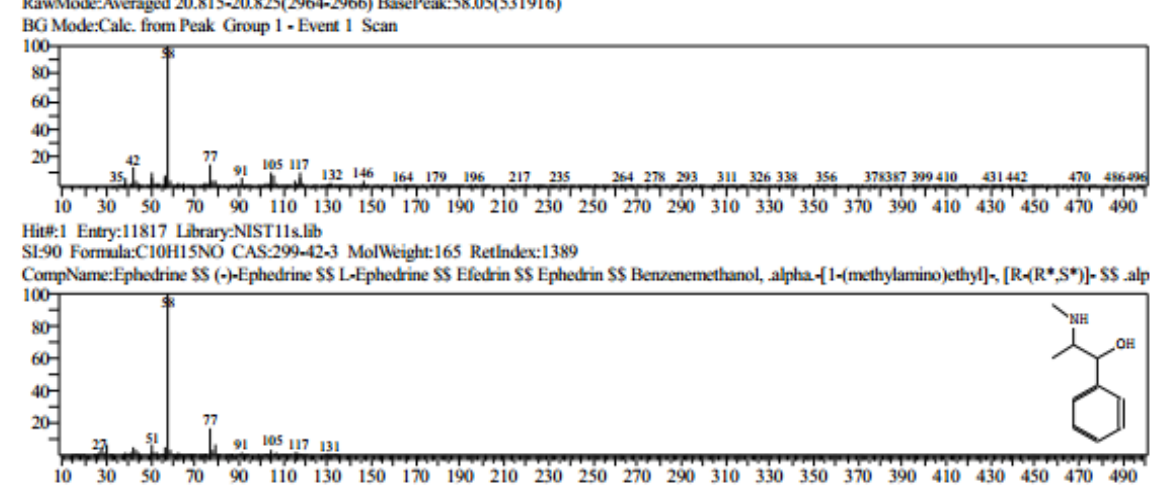
Figure 10. Fragmentation and structure elucidation of isolated AS2 compound by GC/MS. Table 4. Isolated AS2 compound identified by GC MS (29-30)